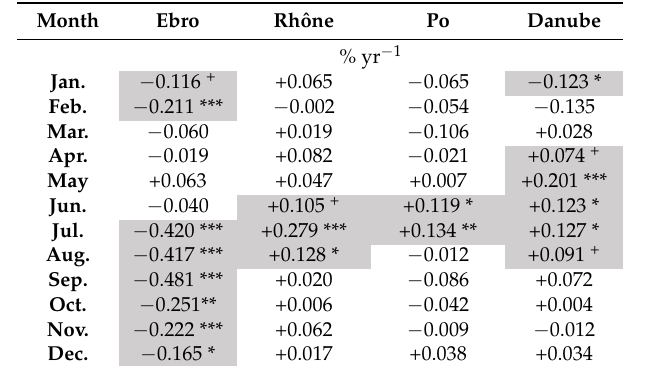
Table A2. Slope (% yr − 1 ) of maximum monthly flow variability ([Q max − Q min ] × 100/Q max ; %) vs. time (yr) in flow series of Table 1 estimated by MKT and ST. The levels of significance of these trends are highlighted in gray (*** α = 0.001, ** α = 0.01, * α = 0.05, + α = 0.1, no symbols α > 0.1).